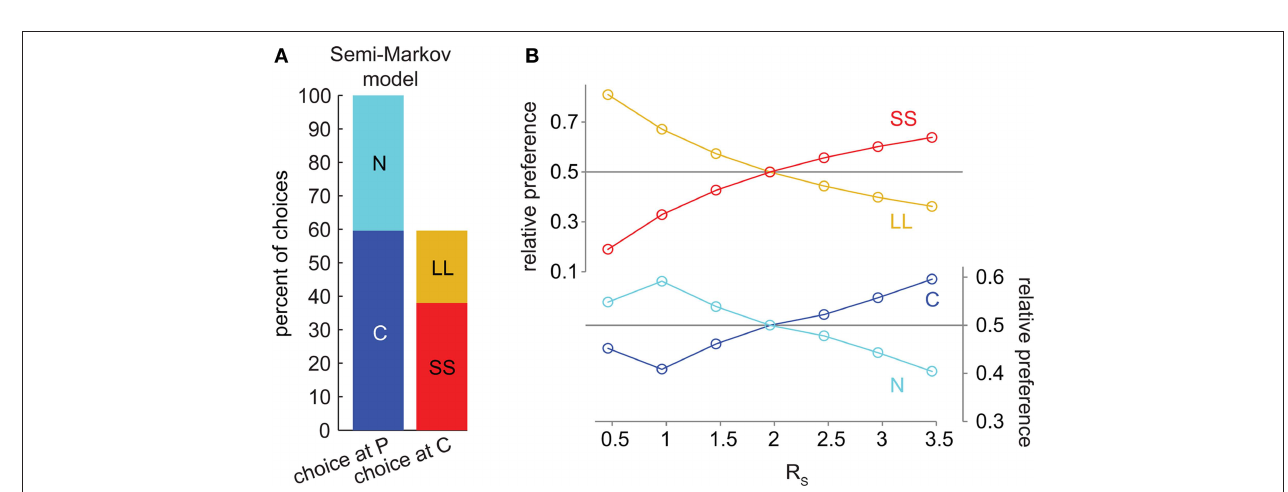
Figure 4 | The HDTD model of hyperbolic discounting cannot produce precommitment behavior. (A) At the selected parameters, SS was preferred to LL and C was preferred to N. This bar graph represents the same data as (B) at R = 1.5. (B) As R increased, the preference for C overtook N exactly at the same S S